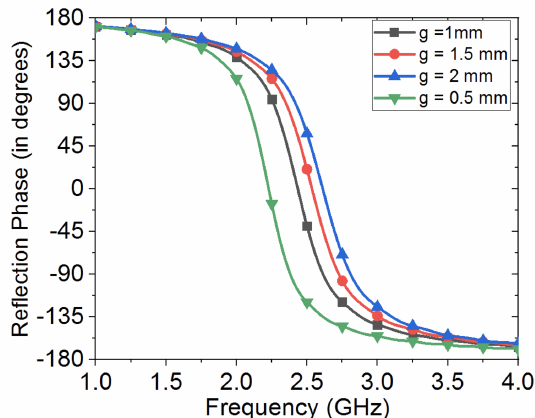
Figure 16. Effect of gap size on operational in-phase reflection frequency band of the HIS structure. Note that periodic boundary conditions were applied in order to mimic a periodic HIS structure. Note that metallic patch size, p , was kept fixed here as 35 mm.